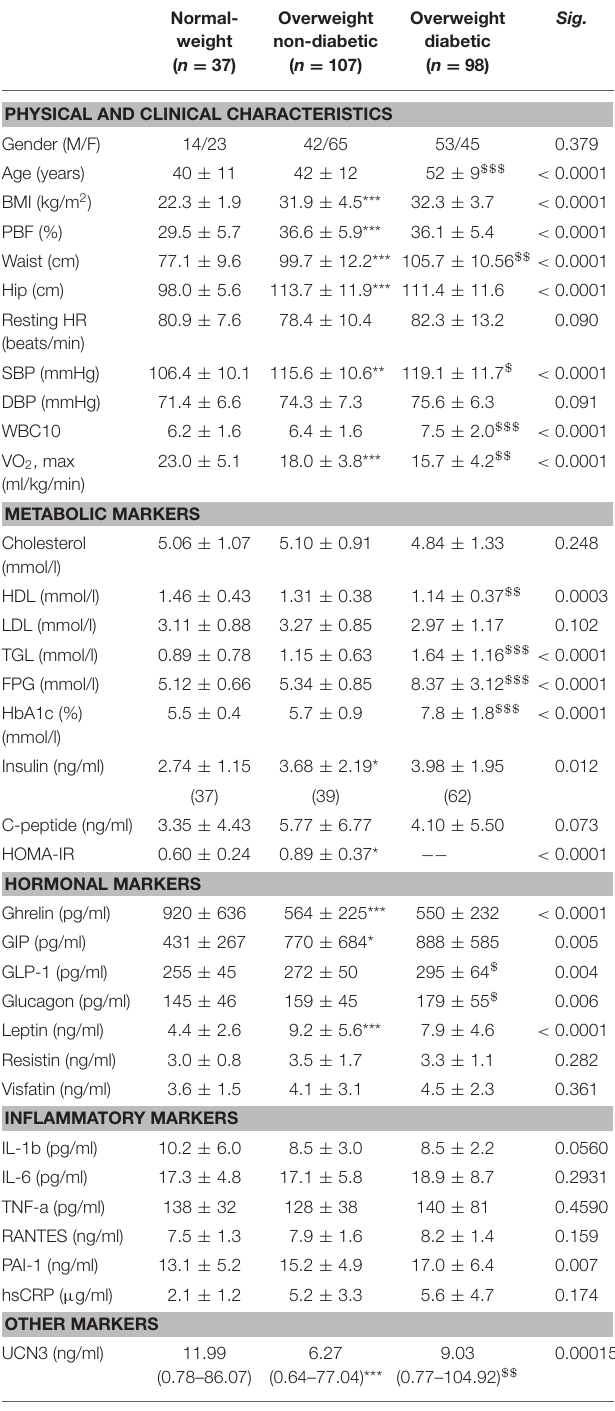
TABLE 1 | Physical, clinical, and biochemical characteristics of the subjects at baseline.